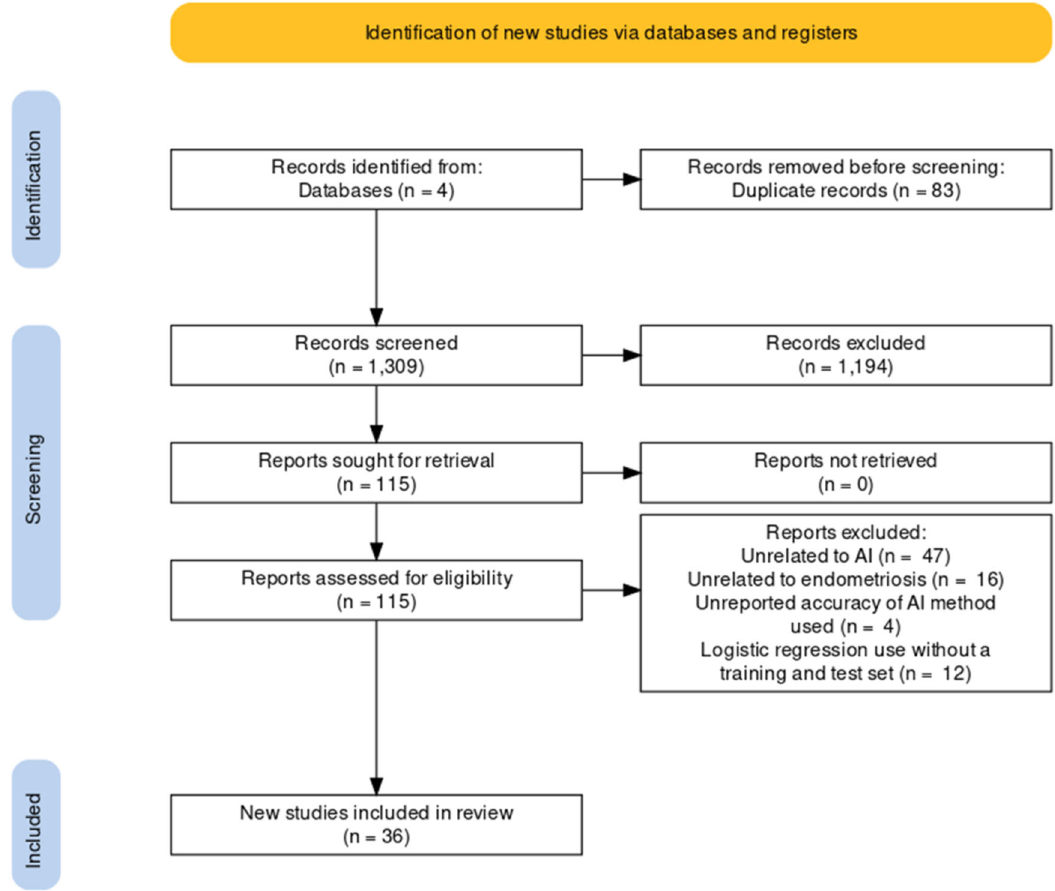
Fig. 2 Work fl ow of the study. Flowchart of study identi fi cation, inclusion, and exclusion